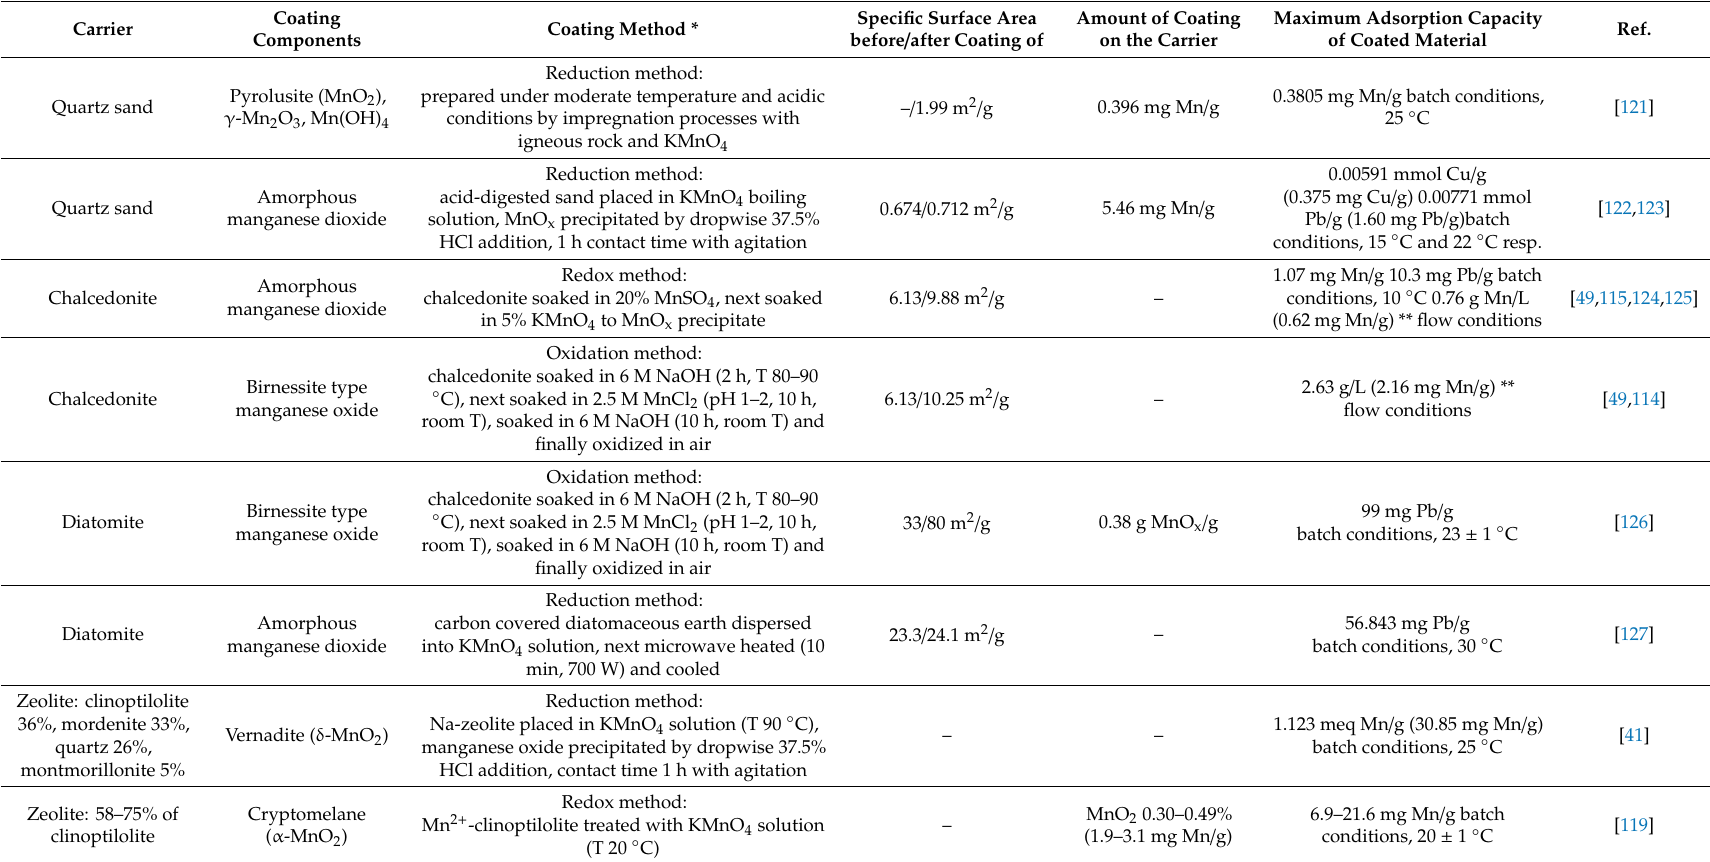
Table 2. Characteristics of chemically coated mineral